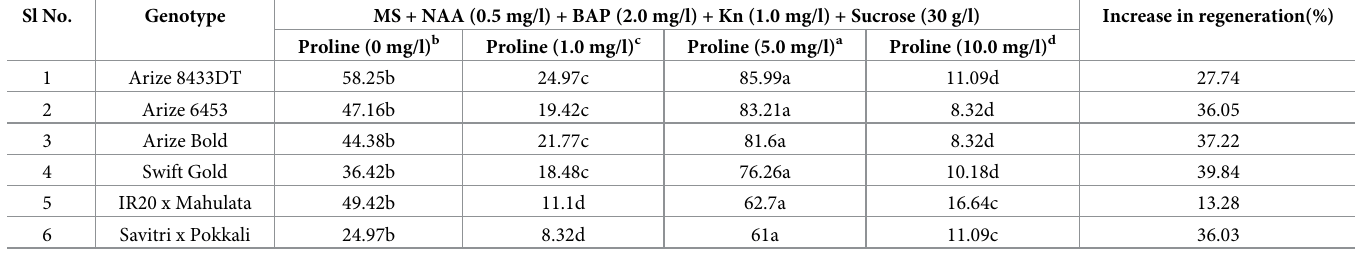
Means sharing the same letter in a column were not significantly different in Duncan’s multiple comparison range test (p < 0.05). � 10 replicates per treatment; repeated